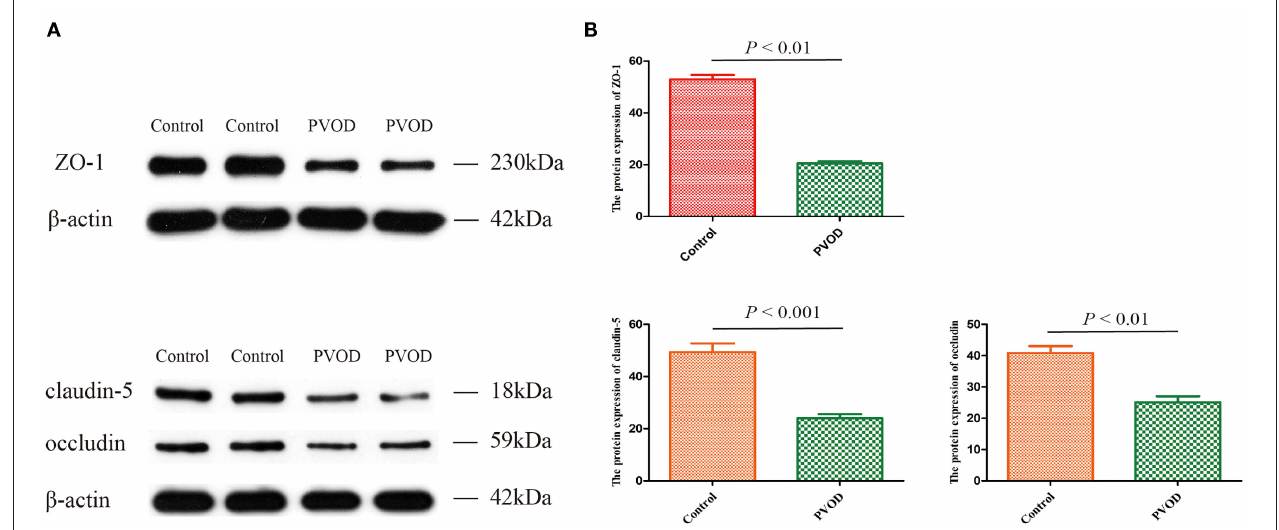
FIGURE 11 | The protein expression of ZO-1, occludin, and claudin-5 in rat. (A) Western blot band of proteins expression. (B) Relative quantitative of ZO-1, claudin-5, and occludin expression in control group and PVOD group. Values are expressed as means ± SD. ZO-1, zonula occludens-1; PVOD, pulmonary veno-occlusive disease. The control group ( n = 4 rats) and the PVOD group ( n = 10